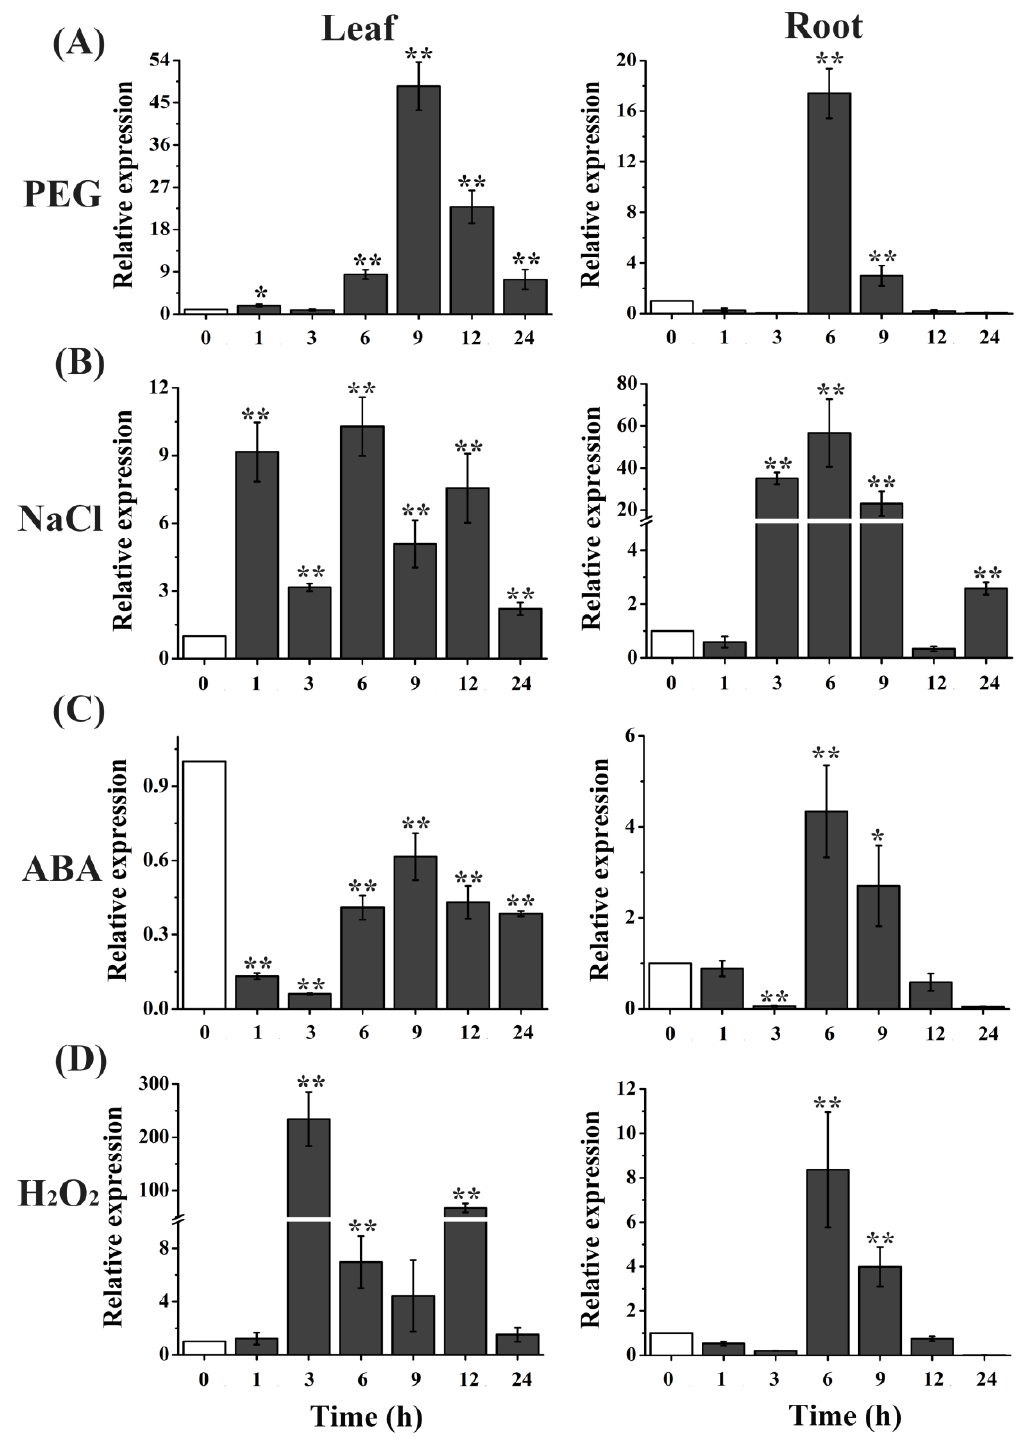
Figure 1. Expression profiles of TaTIP4;1 after treatment with PEG6000, NaCl, ABA and H 2 O 2 in wheat. Two-week-old wheat seedlings were treated with 10% PEG 6000 ( A ), 200 mM NaCl ( B ), 100 μM ABA ( C ) or 10 mM H 2 O 2 ( D ) for indicated periods of time. qPCR analysis of TaTIP4;1 transcription was performed. TaActin was used as an internal control. Data are mean ± SD (n ≥ 3). Single and double asterisk mean that the data from the treatment samples significantly differed from the control at * p < 0.05 and ** p < 0.01 levels respectively by student’s t test.